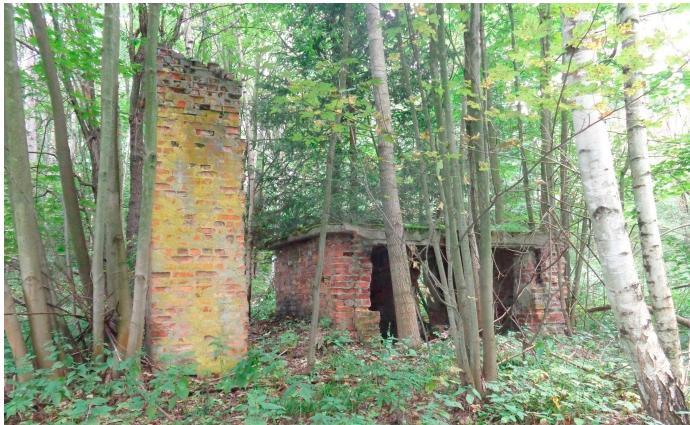
Figure 4. Remains of the camp kitchen, AL Wolfsberg; photo P. Lewandowski.